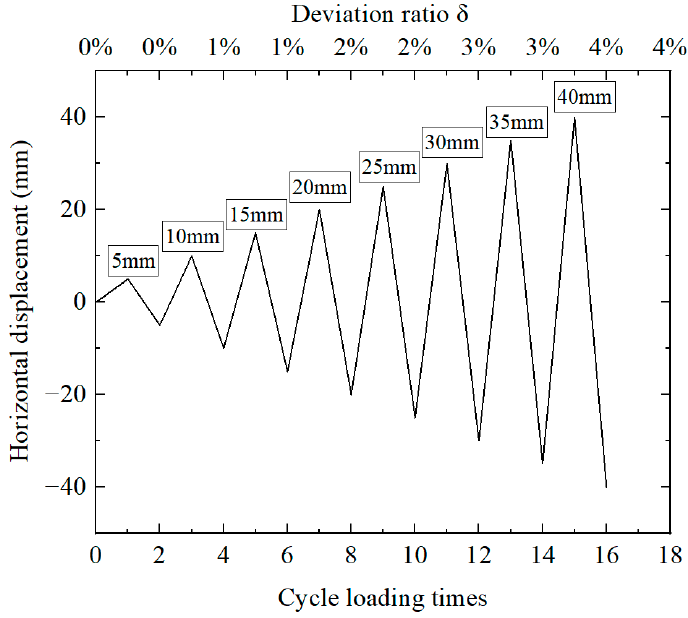
Figure 3. Displacement loading scheme.